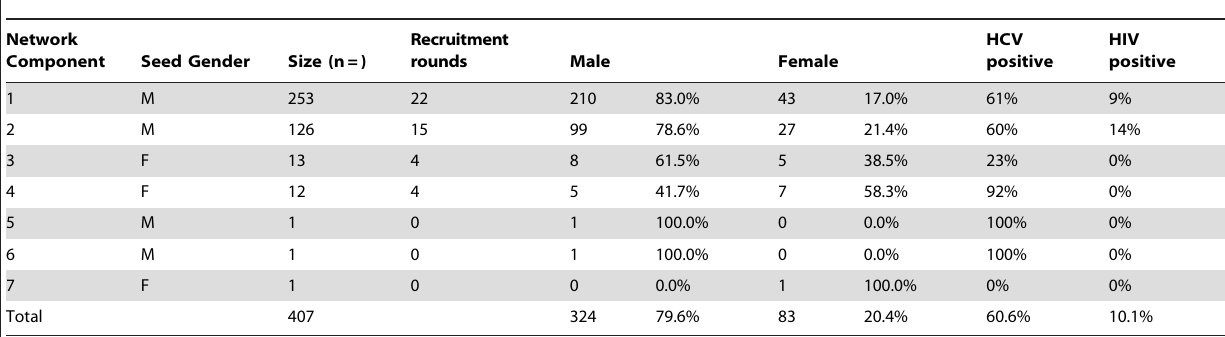
Figure 1. Recruitment network # 2. Both A and B represent the same network of 126 participants. Red circles in A indicate HCV positive and orange circles in B indicate HIV positive participants. Coloured boxes indicate phylogenetically related infections within the network. Green frames indicate phylogenetic link(s) to other network(s) with (coloured) or without (white) links within the network. All branches have a length of 1. Vertical scale indicates recruitment rounds (distance) from seed. doi:10.1371/journal.pone.0022245.g001 Table 1. Characteristics of recruitment